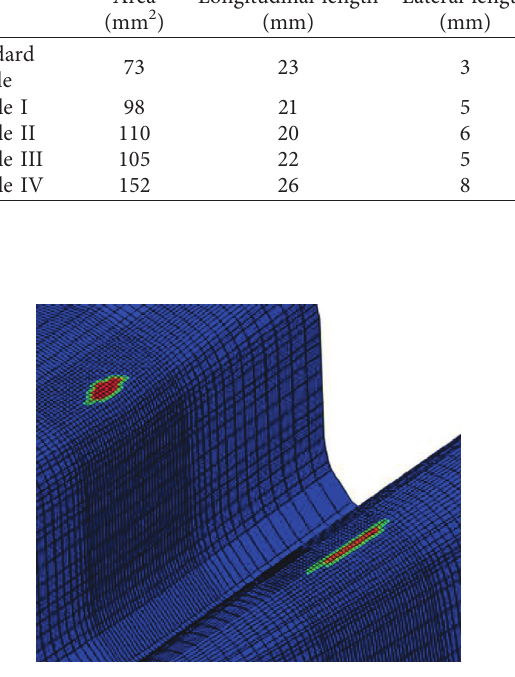
Figure 12: Contact status on the nose and wing